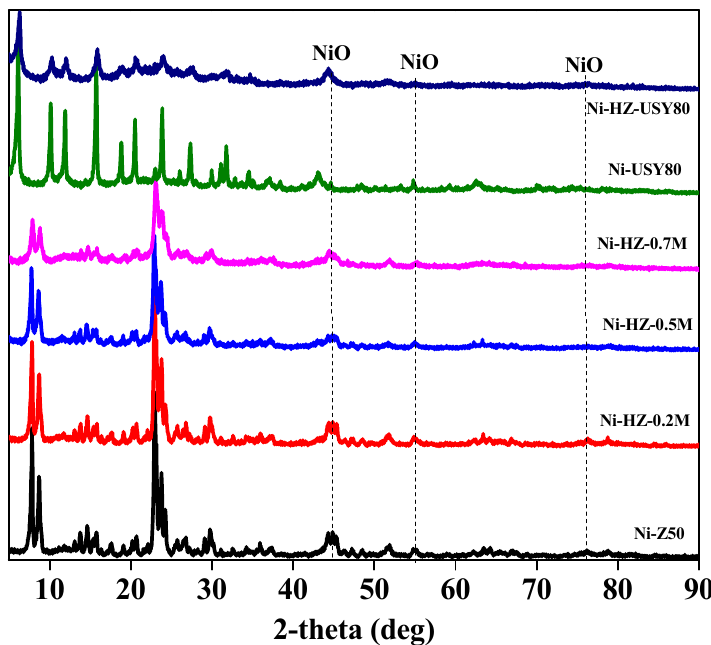
Figure 1. XRD patterns of Ni-supported hierarchical zeolites Ni-Z50; Ni-HZ-0.2 M; Ni-HZ-0.5 M; Ni-HZ-0.7 M; Ni-USY80, and Ni-HZ-USY80.